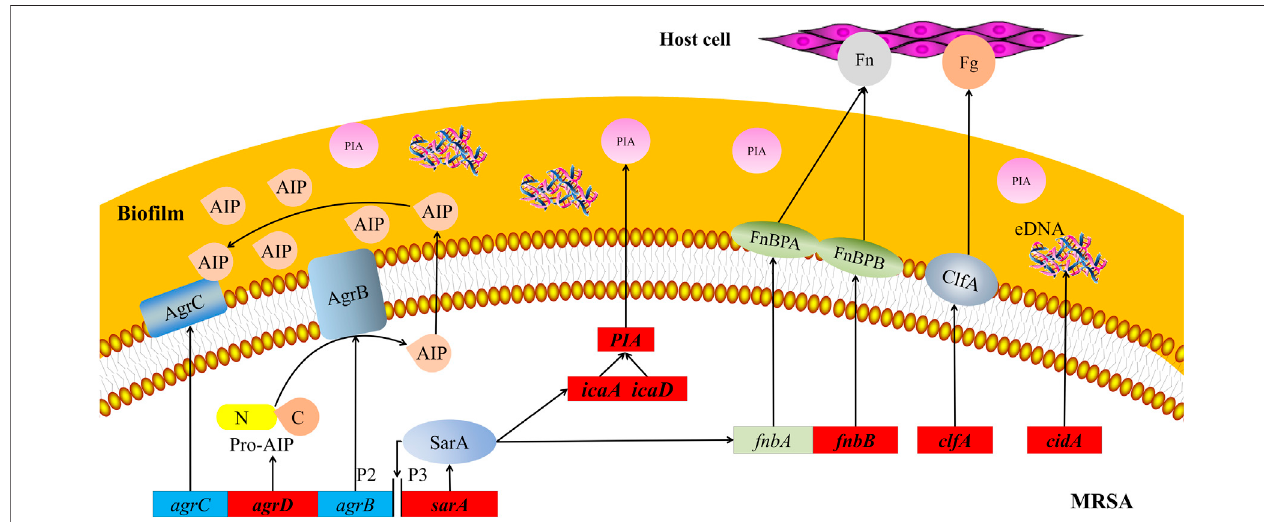
FIGURE 8 | Schematic map of pathways related to MRSA bio fi lms. Red boxes represent MRSA genes that are downregulated by treatment with 25 mg/ml AS. agrB , agrC, and agrD ,accessorygeneregulatorsB,C,andD;AIP,autoinducerpeptide; clfA and clfB ,clumpingfactorsAandB;eDNA,extracellularDNA;Fg, fi brinogen; Fn, fi bronectin;FnbAandFnbB, fi bronectin-bindingproteinsAandB; icaA and icaD ,intercellular adhesionAandD;MRSA,methicillin-resistant Staphylococcusaureus ; P2 and P3, promoters 2 and 3; PIA, polysaccharide intercellular adhesion; and sarA , staphylococcal accessory regulator.